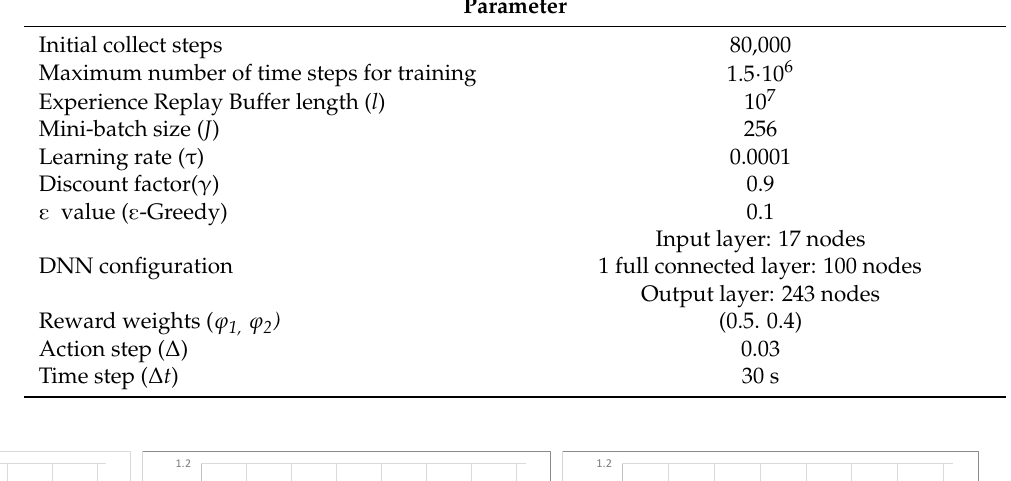
Table 3. Configuration of the hyperparameters of the DQN-MARL capacity sharing solution.